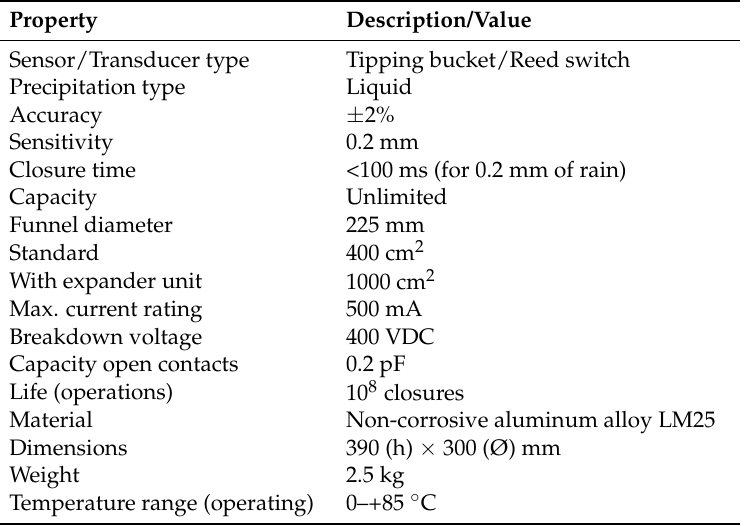
Table 1. Specifications of rain gauges.